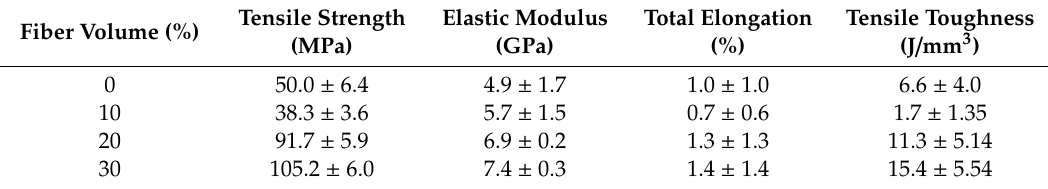
Table 2. Results for tensile test of the epoxy–caranan composite.